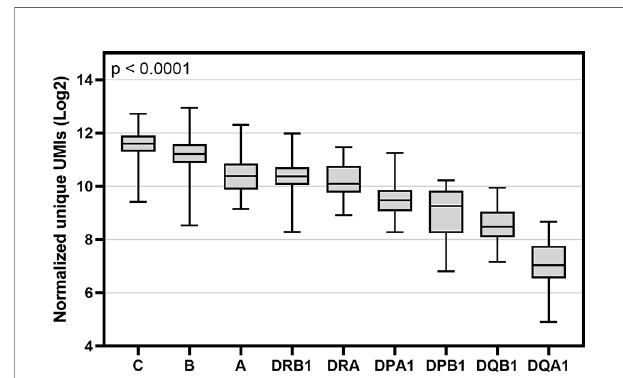
FIGURE 3 | Box and whisker plot of gene-speci fi c expression of nine HLA genes of 50 individuals. Y-axis indicates the sum of normalized unique UMIs (Log2) of two alleles of cDNA data and X-axis indicates the names of nine HLA genes. Boxes indicate the lower quartile, median and upper quartile. Data were compared using a Kruskal-Wallis